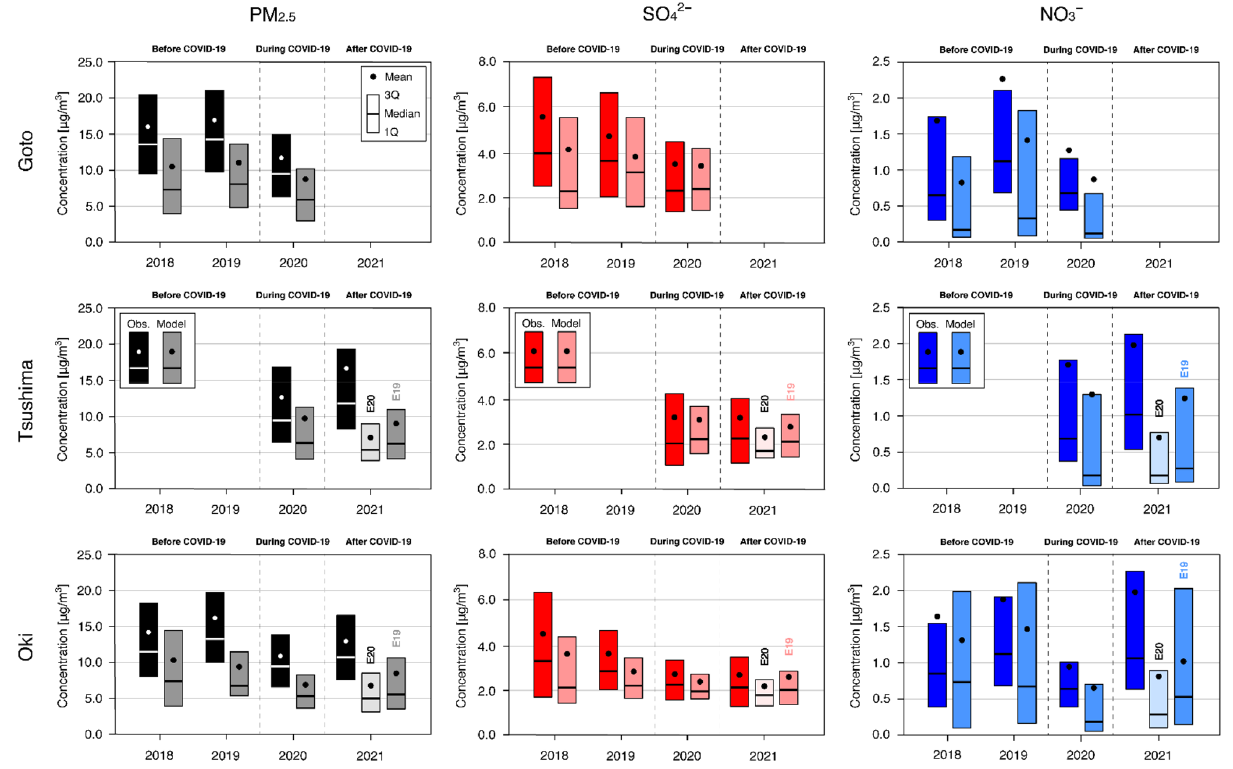
Figure 2. Two-month (February and March) average of (left) PM 2.5 , (centre) SO 4 2− and (right) NO 3 − concentrations from 2018 to 2021 at (top) Goto, (middle) Tsushima and (bottom) Oki. For each year, the observation is shown on the left and the model is shown on the right. For 2021, the model experiments of M21E20 and M21E19 are shown by the lighter colour and darker colour and denoted as E20 and E19,